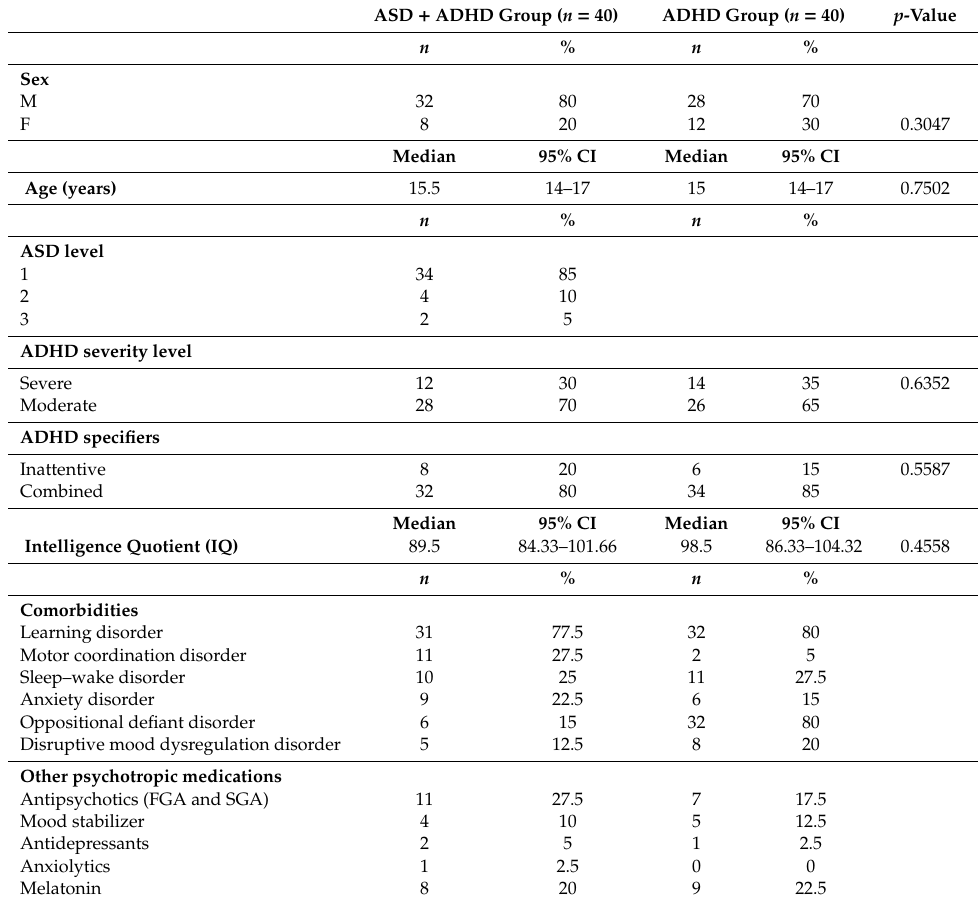
Table 1. Demographic and clinical characteristics of the sample, comorbidities and other psychotropic medications beside methylphenidate